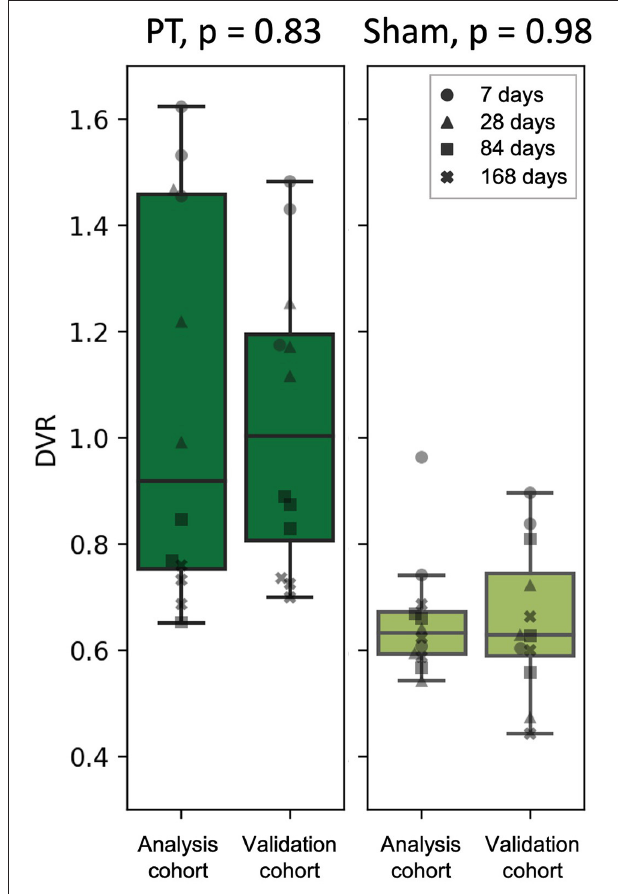
FIGURE 6 | DVR calculated using Logan plot with IDIF (analysis cohort) against DVR estimated from the linear fits (validation cohort) for the PT mice (left) and the sham mice (right) . The marker shape represents the time after the surgery.